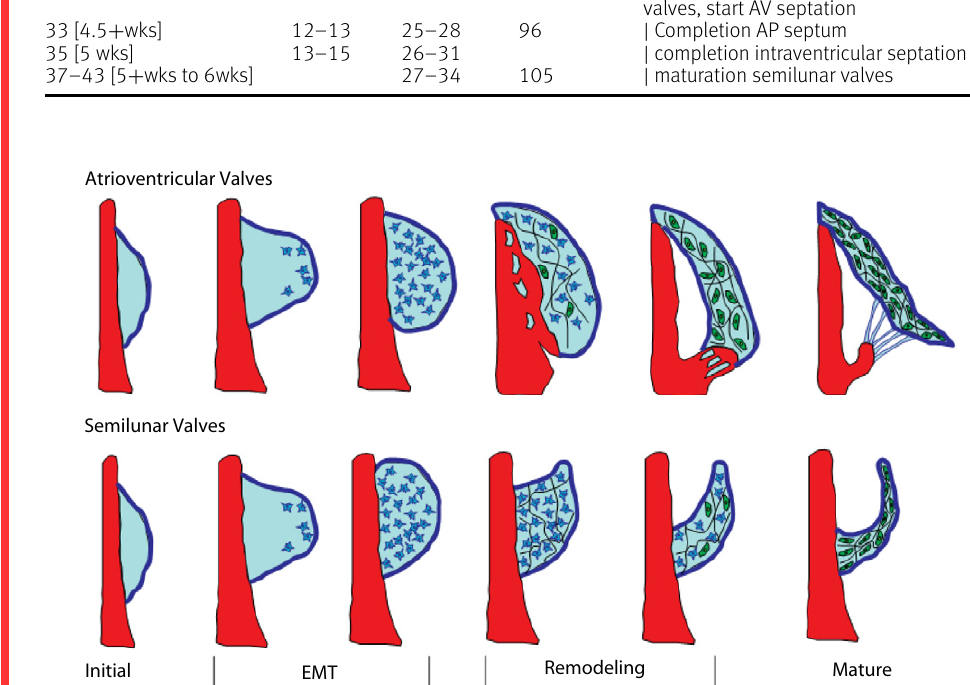
Figure. 2 Schematic of the morphogenic transition from globular cardiac jelly to fibrous cusps/leaflets of the semilunar and atrioventricular valves. Taken from